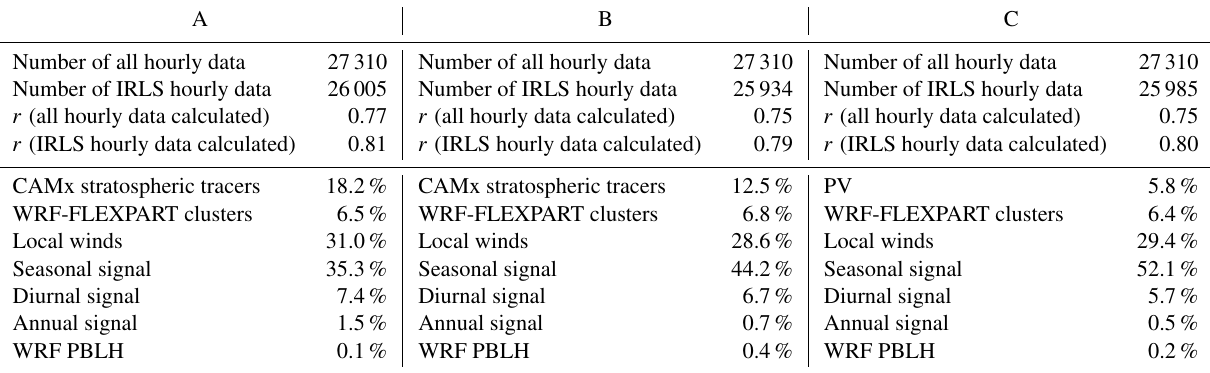
Table 2. Multi-linear regression model for hourly ozone (2011–2014) for three different models and the contribution of groups of input variables to the variance (%) of the ozone time series. PV: potential